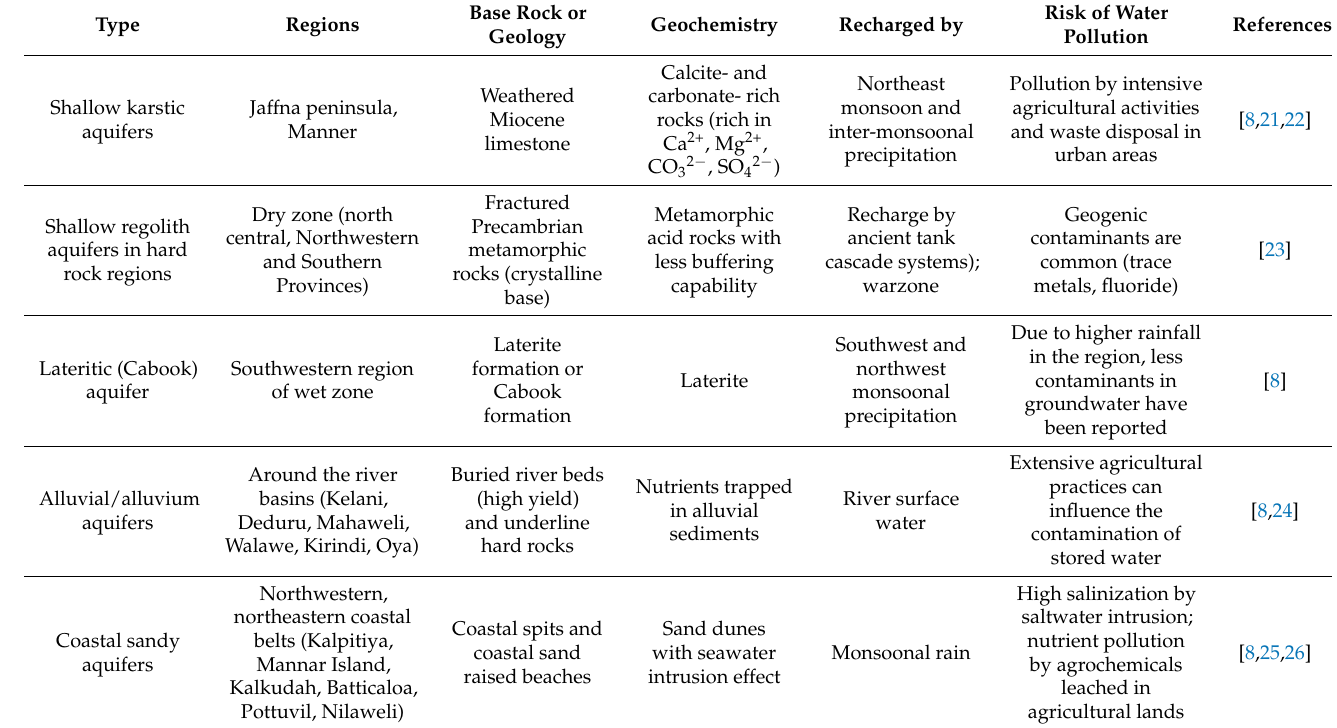
Table 1. Characteristics of different aquifer types in Sri Lanka and their vulnerability for